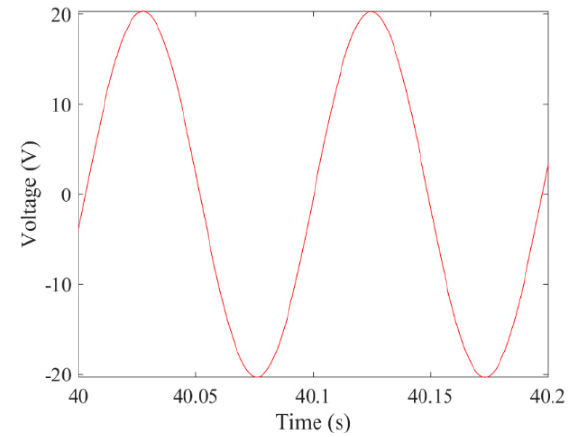
Figure 6. Fast Fourier transform (FFT) of the steady-state part of the voltage–time response. ( U = 4.0 m/s).